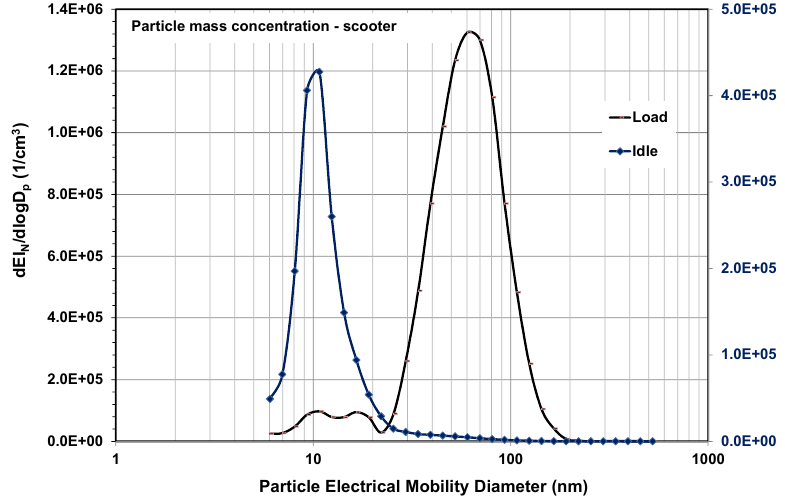
Figure 4. Particle number distribution obtained for scooter.